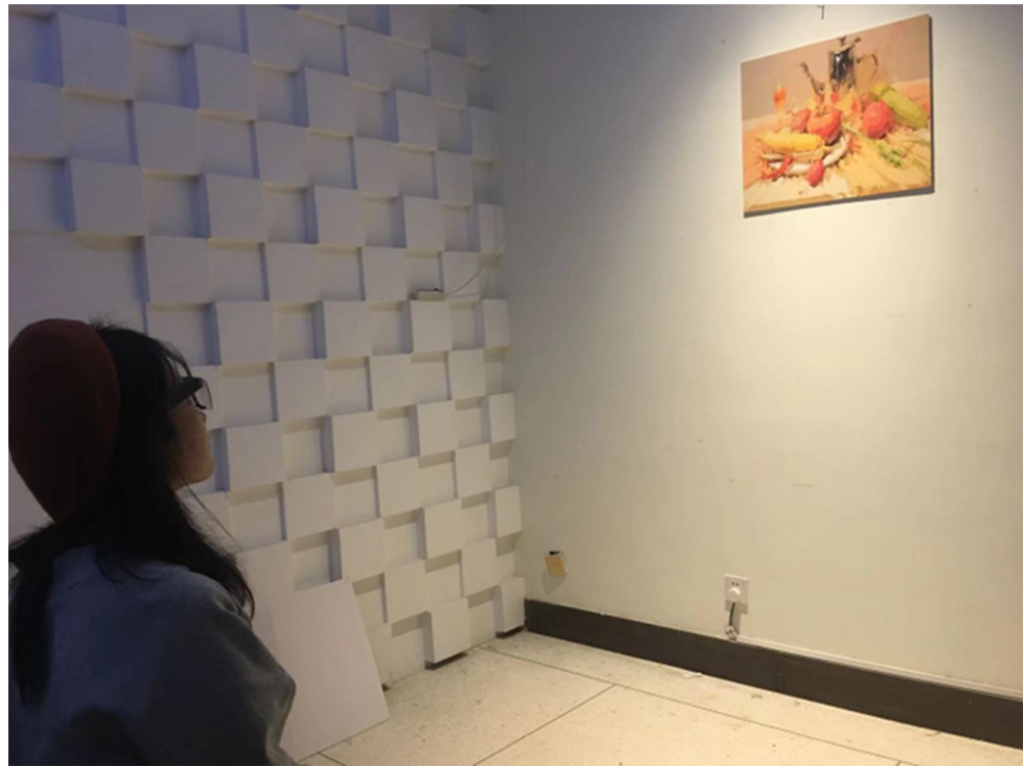
Figure 1. Experimental environment.